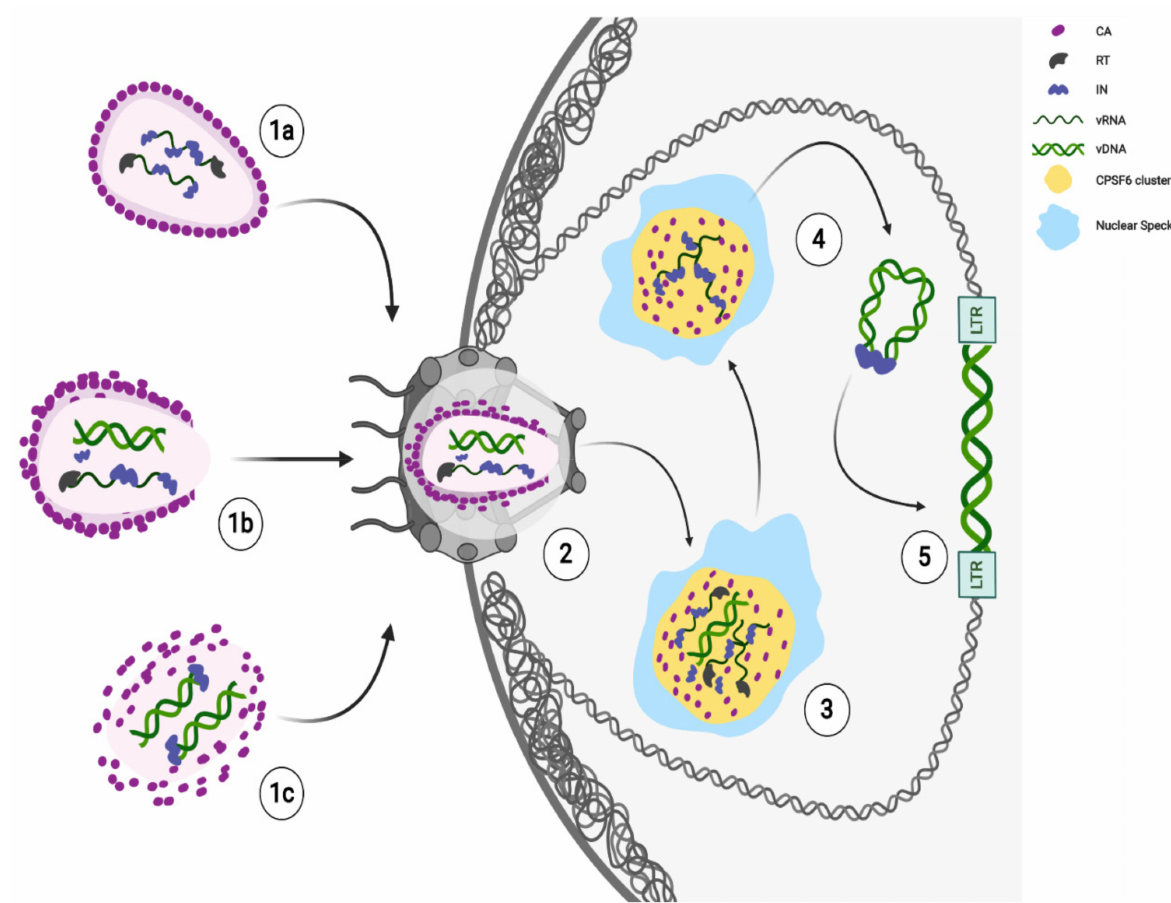
Figure 1. Ongoing model of HIV-1 early steps. HIV-1 cores are released in the cytoplasm after membrane fusion. Likely, the core state reflects different stages of reverse transcription. Different potential core states can reach the nucleus: nearly intact ( 1a ), remodeled ( 1b ), or partially uncoated ( 1c ). Next, HIV-1 core remodels to translocate through the nuclear pore complex (NPC) channel and CA proteins interact with Nucleoporins (Nup358/RanBP2, Nup153) for the translocation of RTCs/PICs ( 2 ). The completion of reverse transcription and maturation of functional PICs ( 3 ) occur in HIV-1 MLOs, thanks to the CPSF6 clusters formation in SC35 nuclear speckles (NSs). HIV-1 mature PICs separate from HIV-1 MLOs ( 4 ); as long as incoming viral RNA is retained inside, viral components, like the IN proteins remain accumulated in the clusters ( 4 ). Integration may occur in active chromatin regions in proximity of the nuclear speckles and of the nuclear envelope ( 5 ). Created with